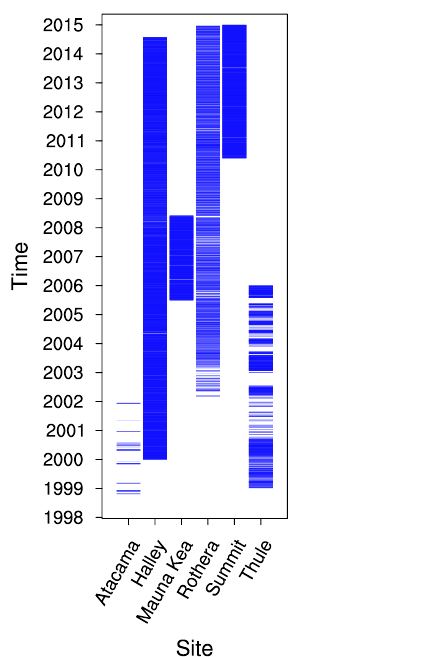
Figure 2. Time coverage of the background climatologies defined by the available radiosonde data from each site. Instrument details are given in Table 1.